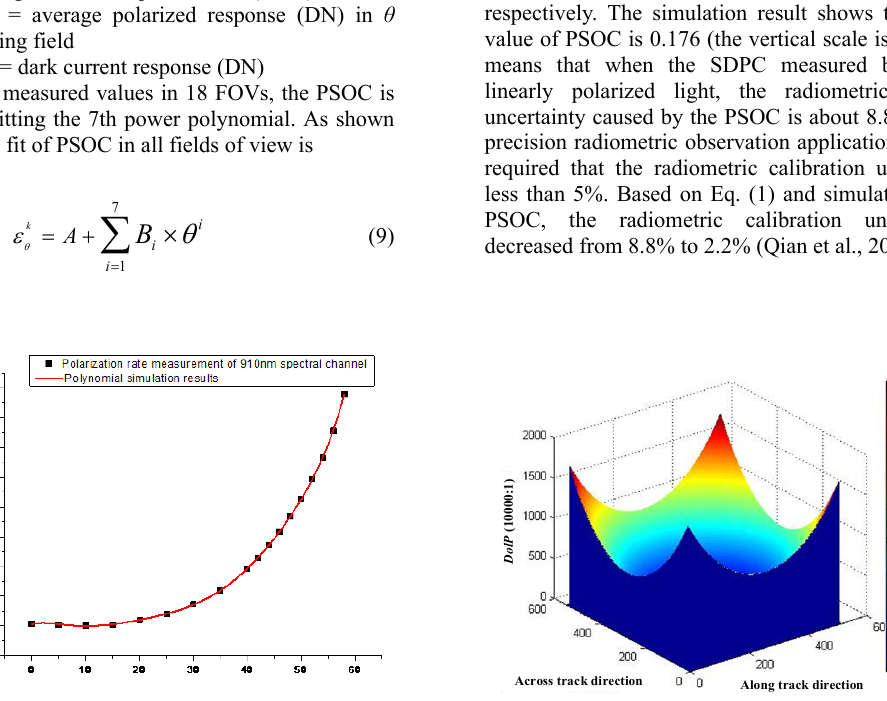
Figure 5. DolP measurement in 18 viewing fields (left) and DolP measurement model (right)in full FOV